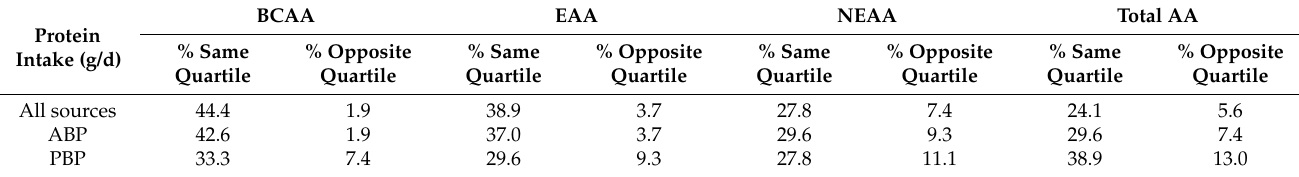
Table 7. Cross-classification between protein intake at 12M and plasma amino acids levels.